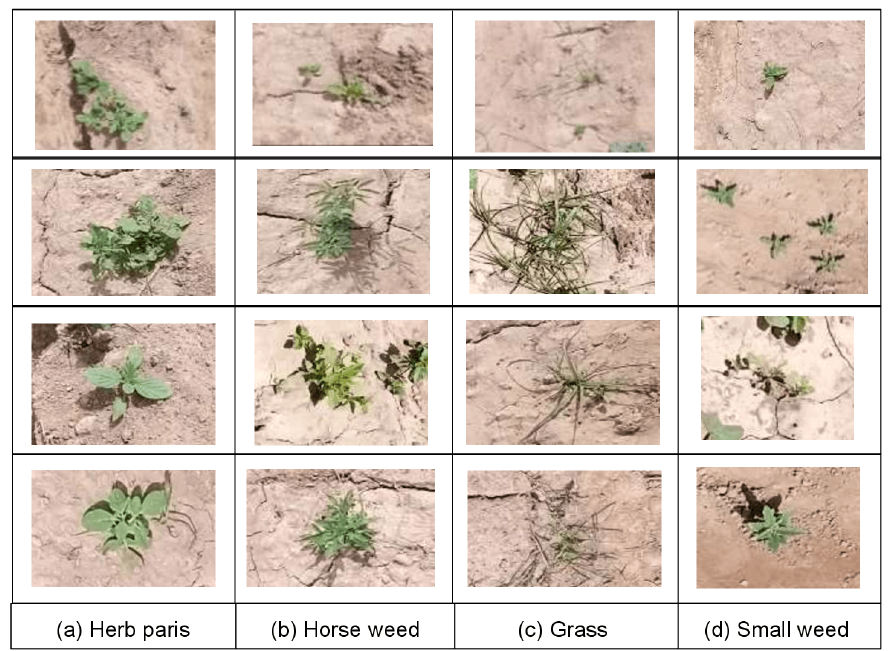
Figure 3. Visuals of the commonly occurred weeds in the fields. Multiple images of each weed species are arranged in